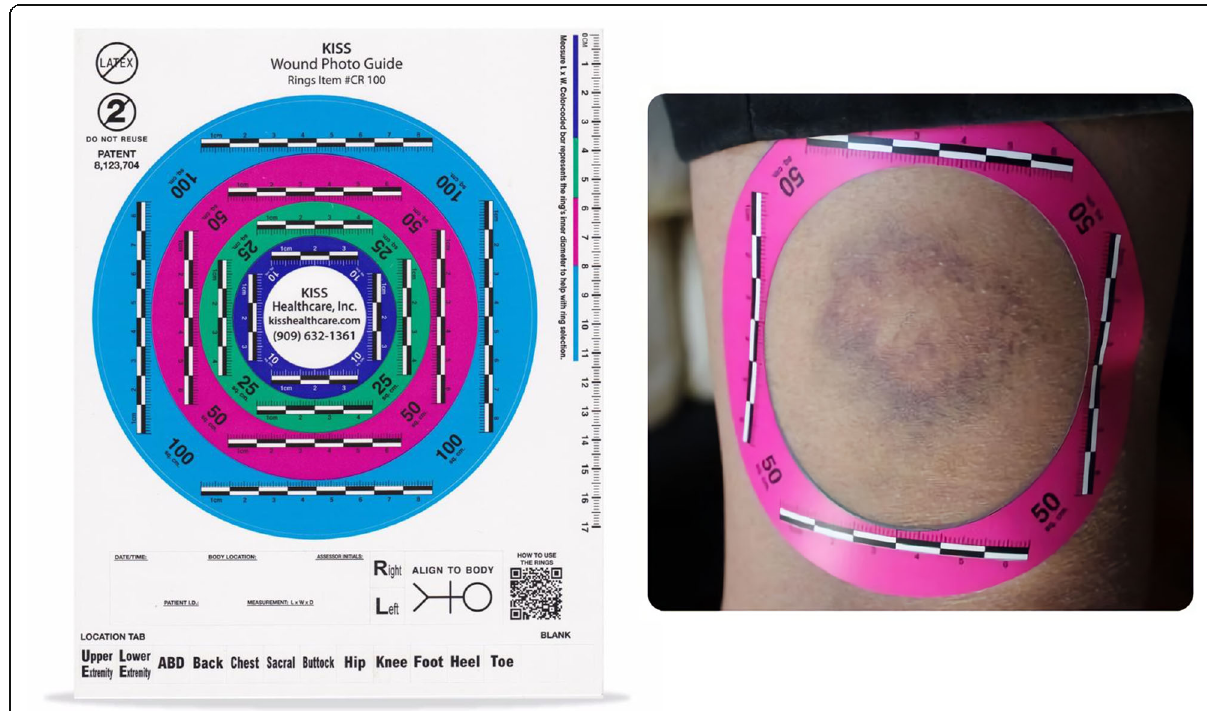
Fig. 2 The KISS wound photo guides — circle scales for back, chest, sacral, buttocks, hip, knee, foot, heel and toe (left). Application of the circle scale over an injured area for taking photography (Right). Reprinted with permission from TJ Richards, CEO, KISS Healthcare, Inc. KISS Wound address the problem of camera positioning by adheres to body ’ s curvatures. The Rulers and L-rulers do not address these